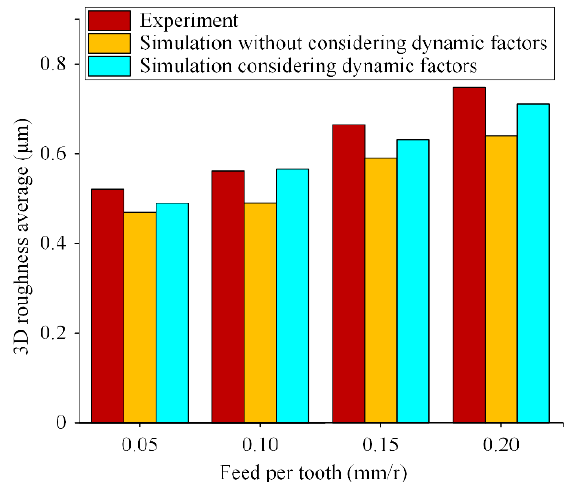
Figure 17. Comparison of surface roughness between experiments and simulations.